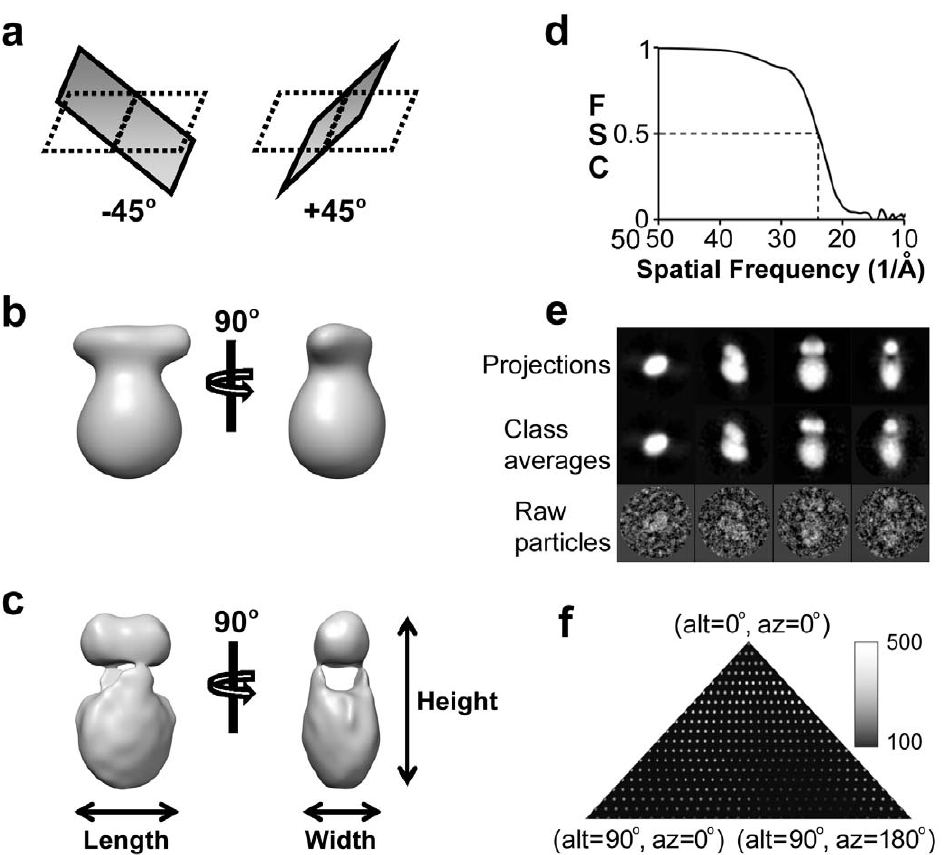
Figure 2. Single-particle reconstruction of bovine AE1. ( a ) Schematic illustration of the OTR data collection method. For each target sample area, two micrographs were recorded with the grid tilted at 2 45 u and + 45 u , respectively. ( b ) 3D map generated by averaging 25 OTR maps. Two orthogonal views, defined as front view (left panel) and side view (right panel), are shown. ( c ) Final map obtained by merging 174,197 particle images with single particle reconstruction method. The map in ( c ) is shown in the same orientations as in ( b ). ( d ) Fourier shell correlation (FSC) coefficient between two reconstructions obtained from even- and odd-numbered particle images. The effective resolution is estimated to be 2.4 nm using the 0.5 FSC cut-off. ( e ) Comparisons of the computed projection, class average, and raw particle. Four representative views (top, tilt, front, and side) are show from left to right, respectively. ( f ) Euler angle distribution of classified particles. The brightness of each point indicates the number of particles used in the class average in that orientation.